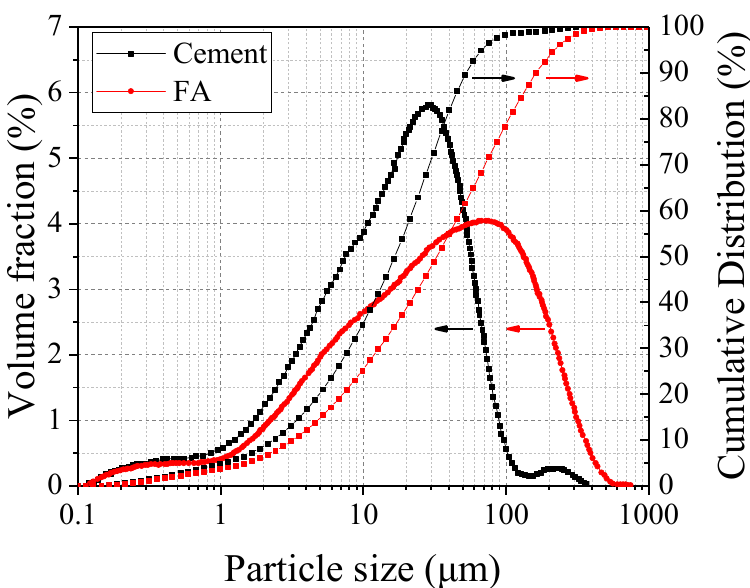
Figure 2. Particle size distribution curves of raw materials. Table 2. Mix proportions of